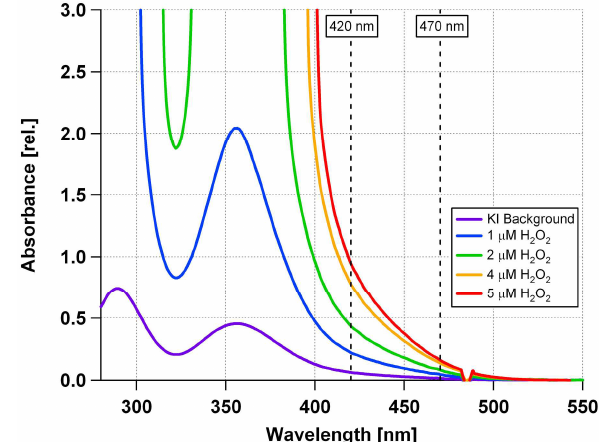
Figure 2. Absorption spectra of triiodide in 0.1 M aqueous HCl / ethanol (1:1 by volume). Triiodide ions were produced from the reaction of hydrogen peroxide (H 2 O 2 ) at different concentrations with iodide ions. The concentration of potassium iodide (KI) was 63 mM. The background spectrum was recorded from the pure KI solution. Absorbance values at 420 nm and 470 nm were taken for calibration.